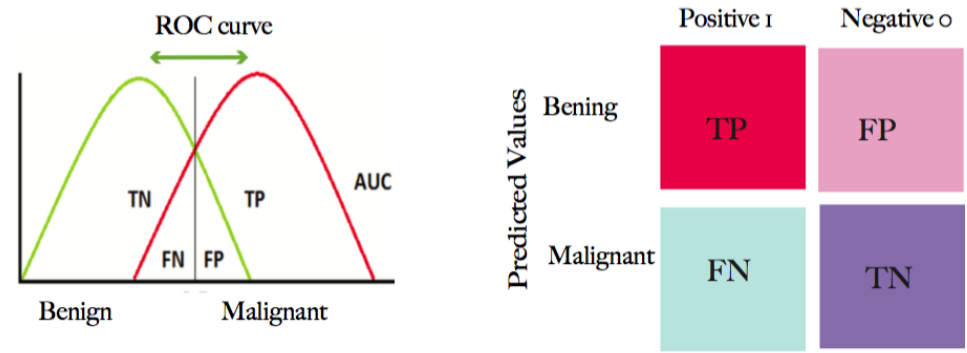
Figure 8. The confusion matrix for the ROC. The number of images correctly predicted by the classifier is located on the diagonal. The ROC curve utilizes the TPR on the y -axis and the FPR on the x -axis.